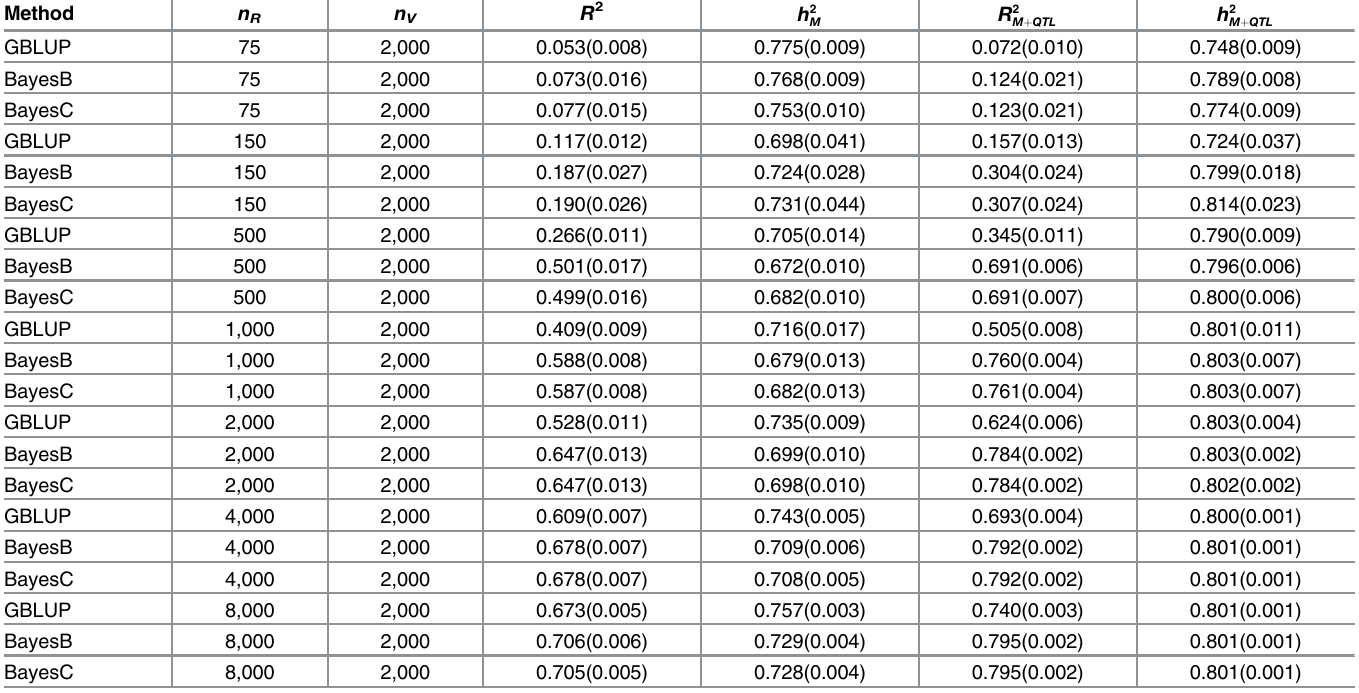
Table 4. Results of